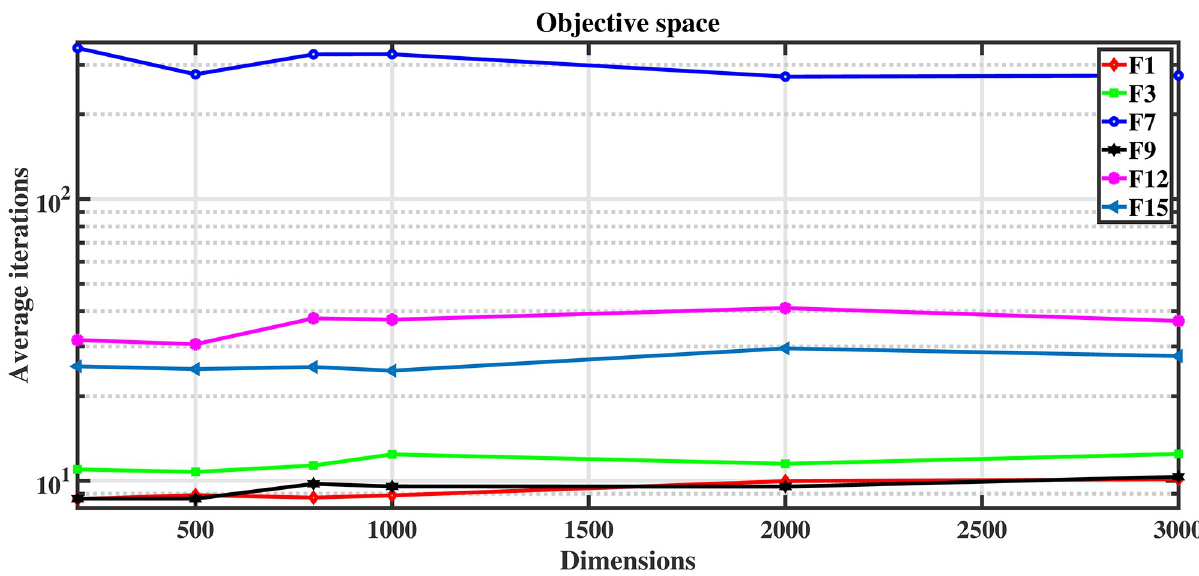
Fig 7. Relationship curve between iteration times and function